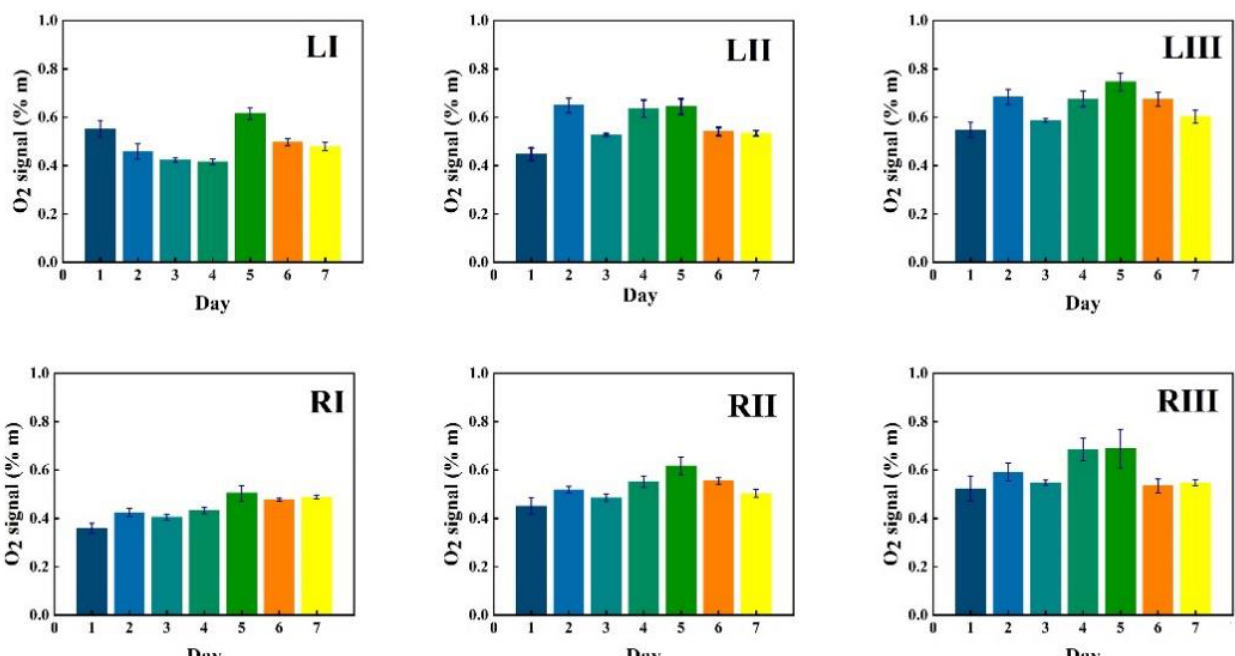
Figure 8. The changes of measured oxygen signal at different locations for volunteer 2 during one week, together with the